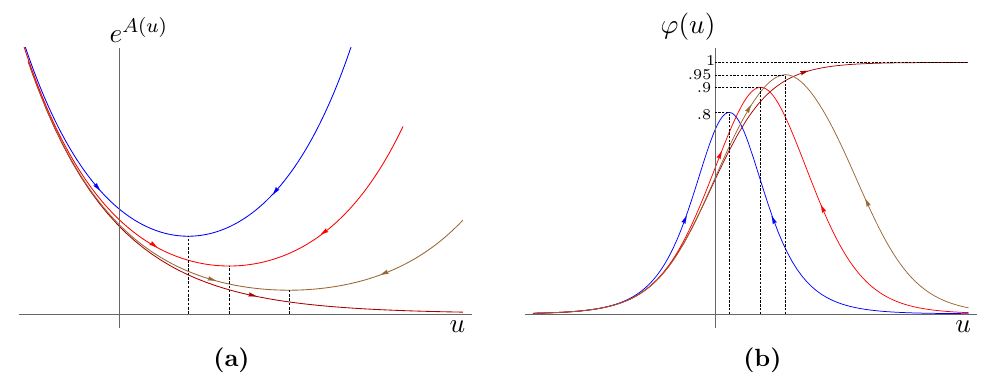
Figure 15. (a): e A ( u ) vs. u and (b) ’ ( u ) vs. u corresponding to the (cid:13)ows in (cid:12)gure 14. The coloring is the same as in (cid:12)gure 14. The dark red curve corresponds to the solution for the (cid:13)at case. The vertical lines represent the re(cid:13)ection points.